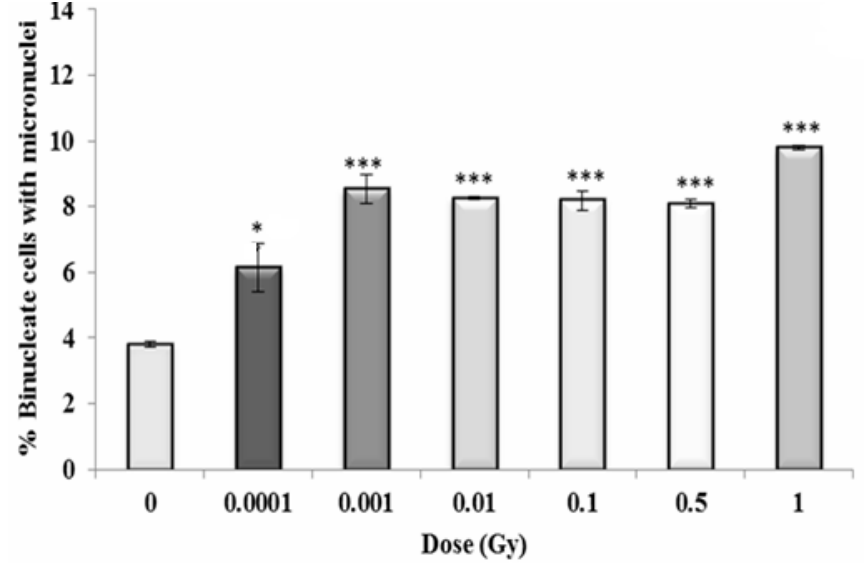
Figure 10. Percentage of binucleate cells containing micronuclei over total binucleate cells in control and irradiated HF19 cells at 5 h following irradiation. The figure represents the combined data for 1000 cells from two independent but parallel experiments as a function of dose. Error bars represent the standard error of the mean of replicate experiments ( ± S.E.M.) from the two independent experiments. p -values were calculated using Fisher’s exact test for comparison of data with associated un-irradiated control. * p ≤ 0.05, *** p ≤ 0.001.